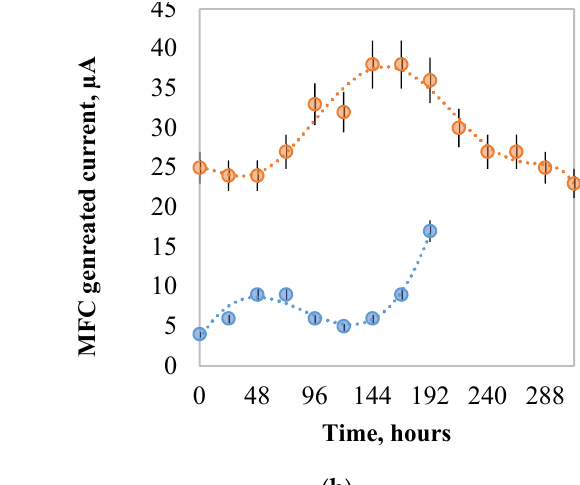
Figure 3. MFC reactor configuration and experimental design used during the COD removal ex- periments; 1—anode, 2—cathode, 3—PEM, 4—external circuit and resistor, 5—reference electrode